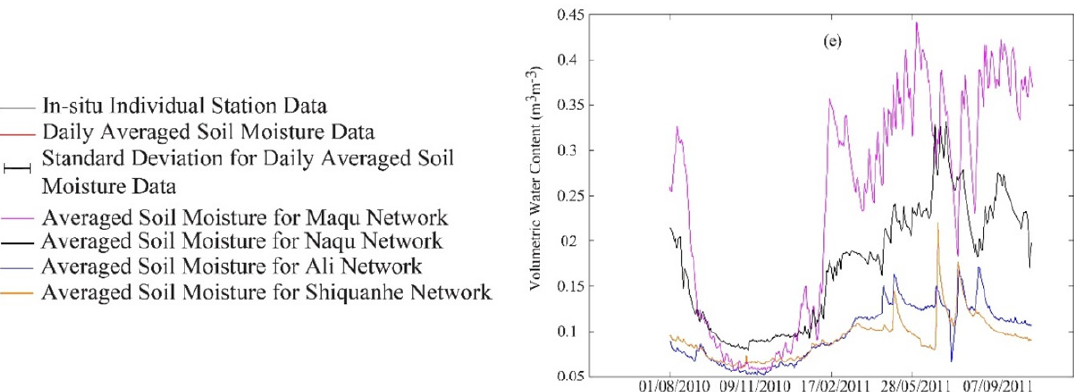
Figure 2. Series of individual station’s observations and the averaged SM data for Tibet-Obs networks between 1 August 2010 and 31 October 2011: ( a ) Maqu; ( b ) Naqu; ( c ) Ali; ( d ) Shiquanhe; and ( e ) averaged soil moisture for different networks.